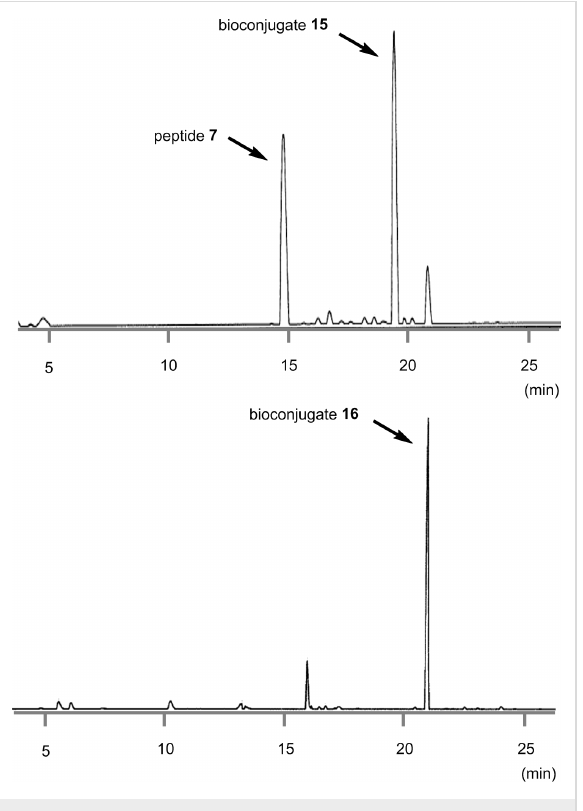
Figure 4: HPLC spectra of the crude protected bioconjugate 15 and the deprotected bioconjugate 16